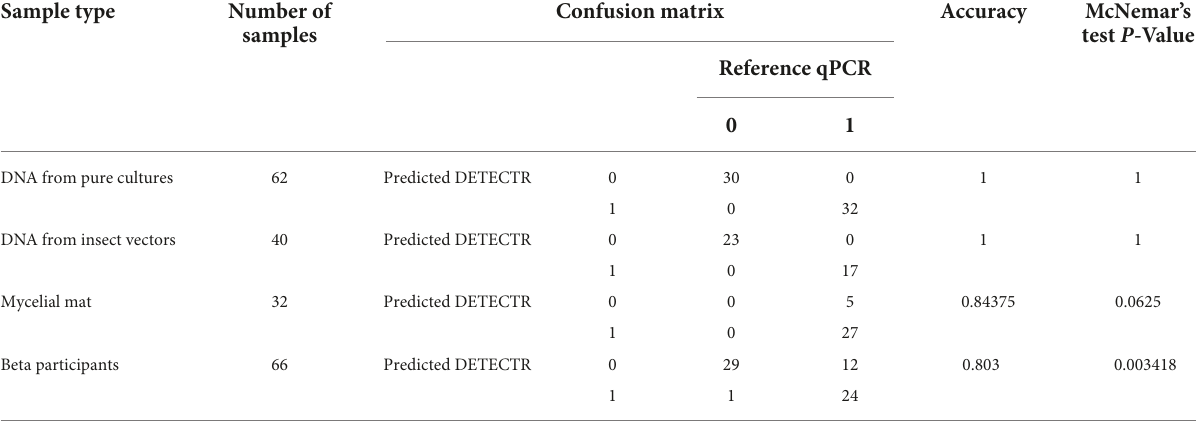
TABLE 2 Confusion matrix showing the comparison of both detection tests on various sample